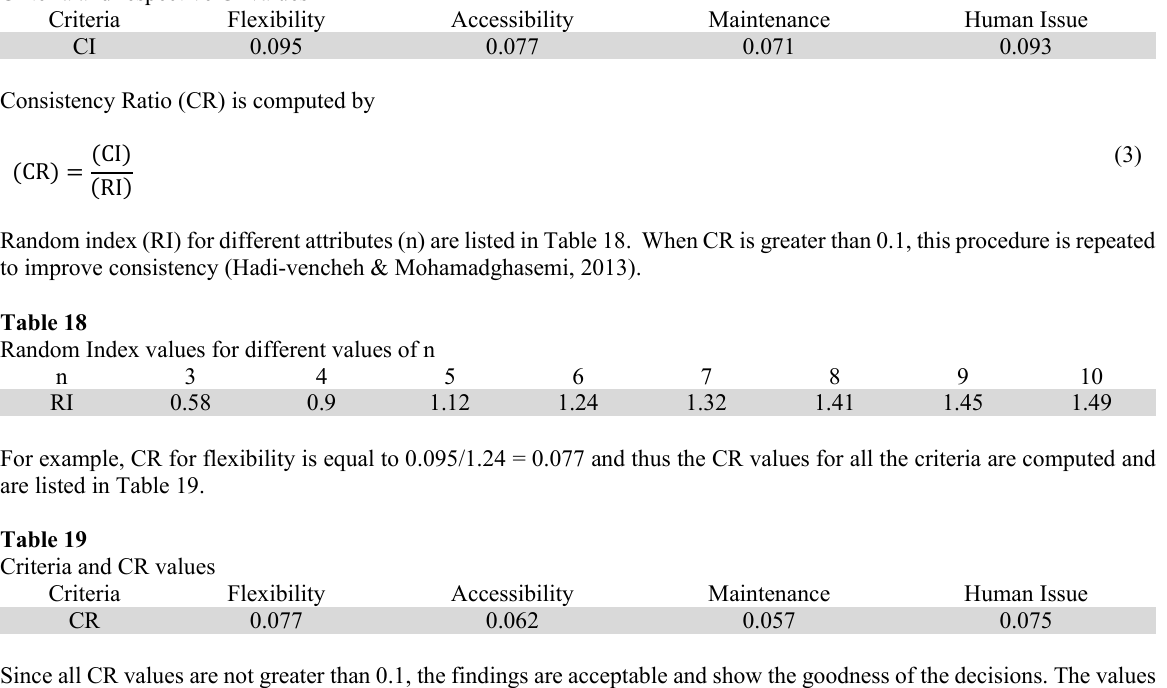
Criteria and respective CI values Criteria Flexibility Accessibility